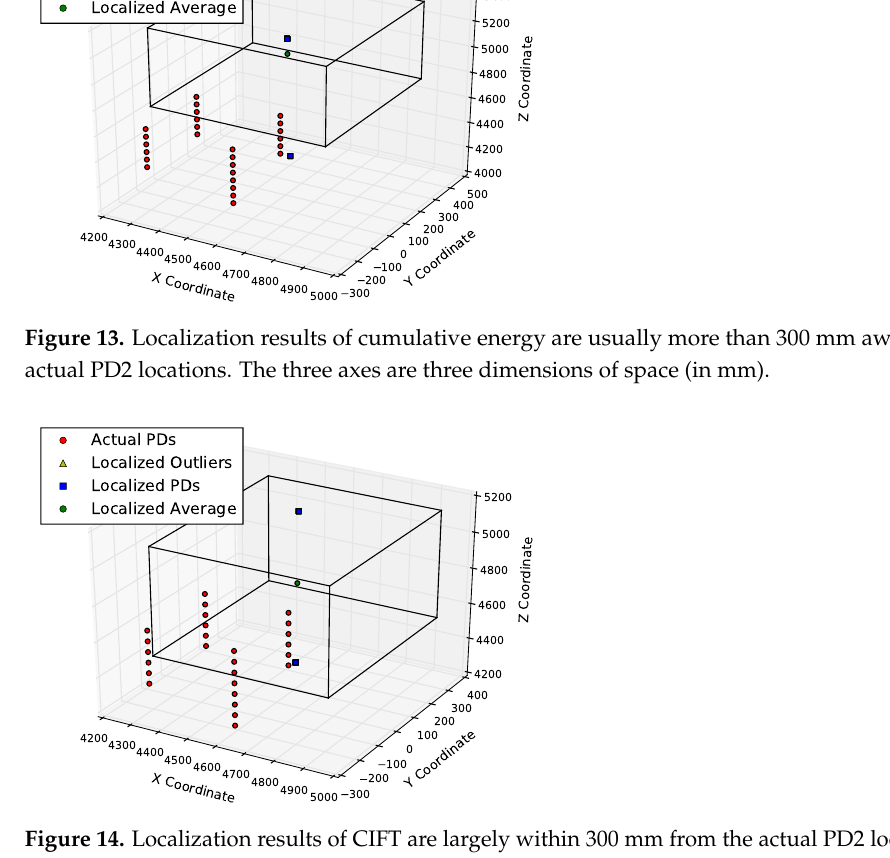
Figure 14. Localization results of CIFT are largely within 300 mm from the actual PD2 locations. The three axes are three dimensions of space (in